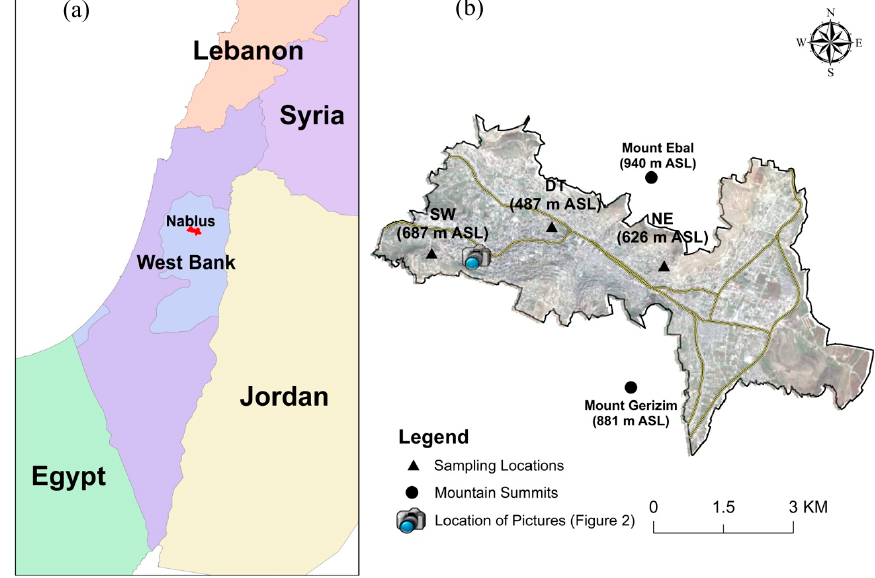
Figure 1. ( a ) Location of the city of Nablus (country map source: [17]); ( b ) the locations of the sampling sites, the mountain summits, and the site where the pictures in Figure 2 were taken (aerial photograph, city boundary, road map, and building map source: